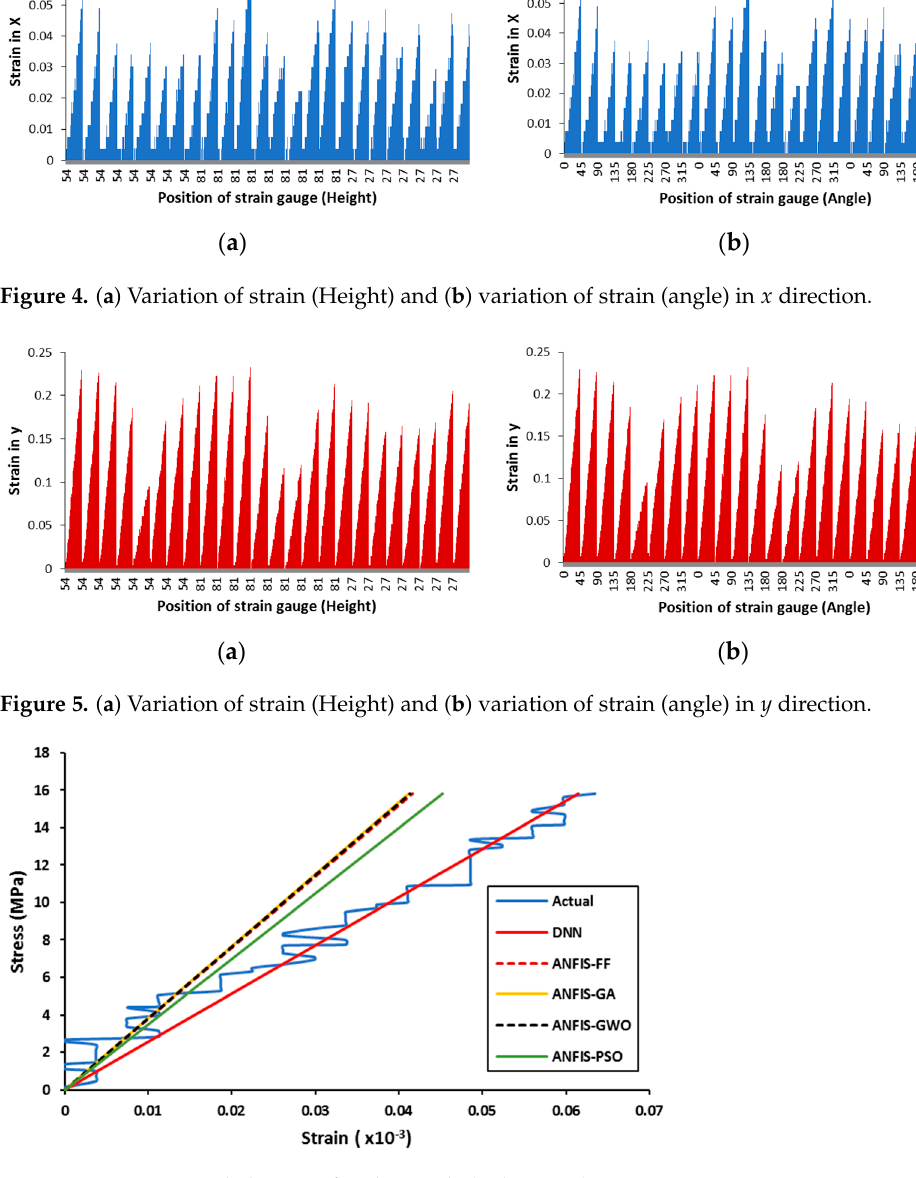
Figure 7. Stress-Strain behavior of rock sample ( 𝑦 direction). 6.2. Actual vs. Predicted For the training and testing datasets in x and y directions, Figures 8–11 shows the predicted strain values calculated by different generated models compared to experi- mental results. The developed model’s performance will increase as the points get closer to the regression line. Based on R 2 values, it can be stated that the DNN model outper- forms other models, whilst the ANFIS-GWO is the least performing model.